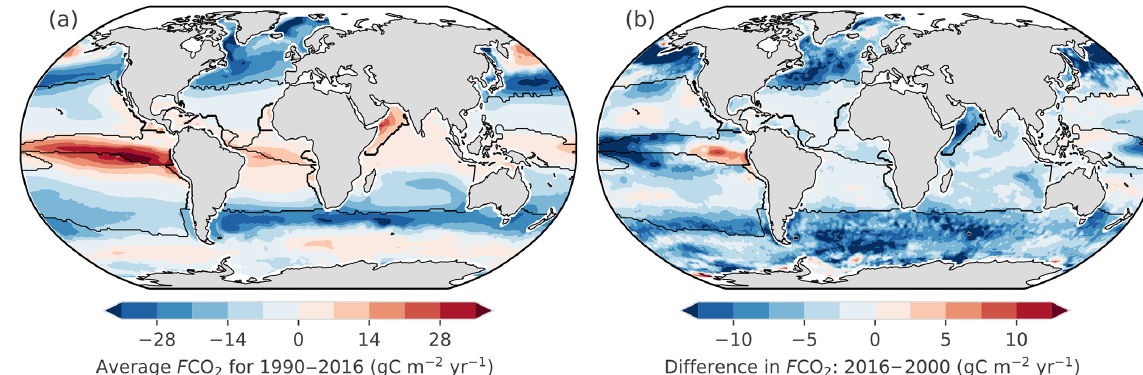
Figure 9. (a) Average sea–air CO 2 fluxes ( F CO 2 ) of CSIR-ML6 for 1990 to 2016, where F CO 2 is calculated as shown in Eq. (2). Negative F CO 2 (blue) indicates regions of atmospheric CO 2 uptake. (b) The differences between F CO 2 in 2016 and 2000, which are the minimum and maximum of global ocean uptake flux ( F CO 2 ) estimates, respectively (for CSIR-ML6 in Fig. 10a). Black lines show the regions as defined in Fig.